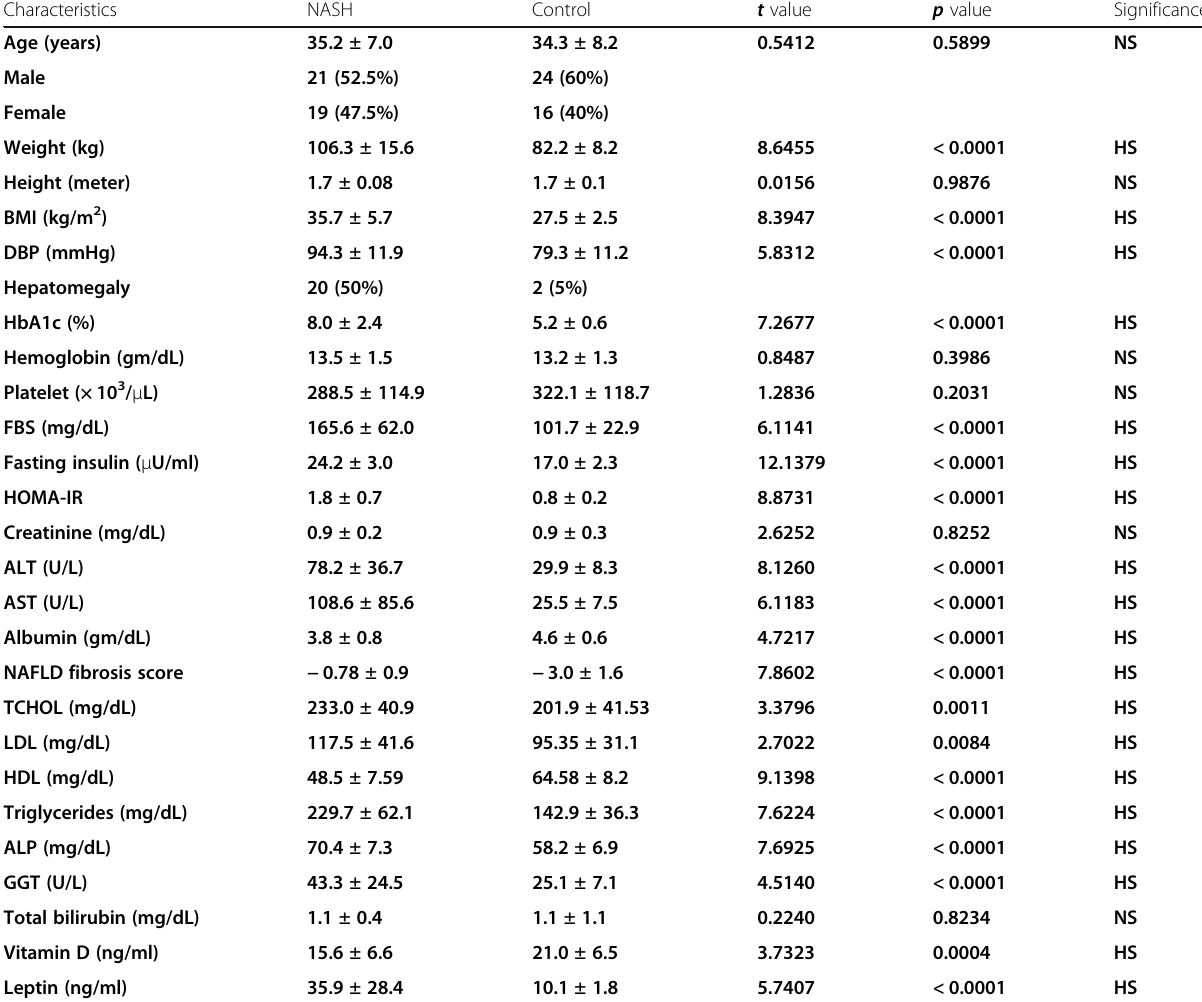
Table 1 Demographic, laboratory, and metabolic parameters of patients with the NASH and control groups